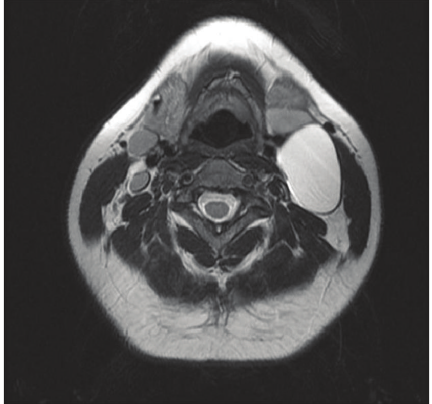
Figure 4: MRI-axial view showing the cystic lesion with high T2 signal.